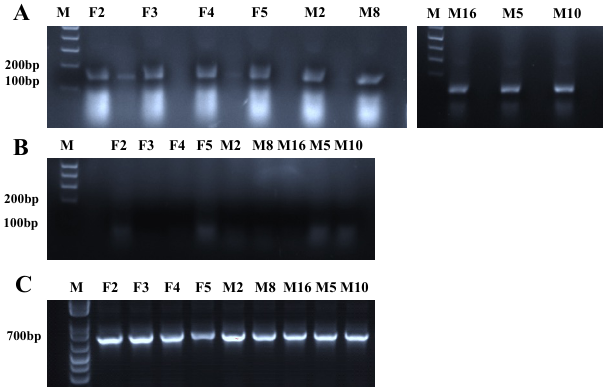
Figure 6. RT-PCR of transgenic mosquitoes. ( A ) Gel displays the presence of a 130 bp fragment, confirming the expression of hRzs in each transgenic mosquito line. ( B ) RT-negative control reactions display the absence of the 130 bp fragment, confirming a lack of DNA contamination. ( C ) Gel displays a 700 bp fragment corresponding to the beta-actin internal control for each line. M = 1 kb plus DNA ladder. F2, F3, F4, F5, M2, M8 and M16 are transgenic mosquito lines expressing hRz #9, and M5 and M10 express hRz #14.